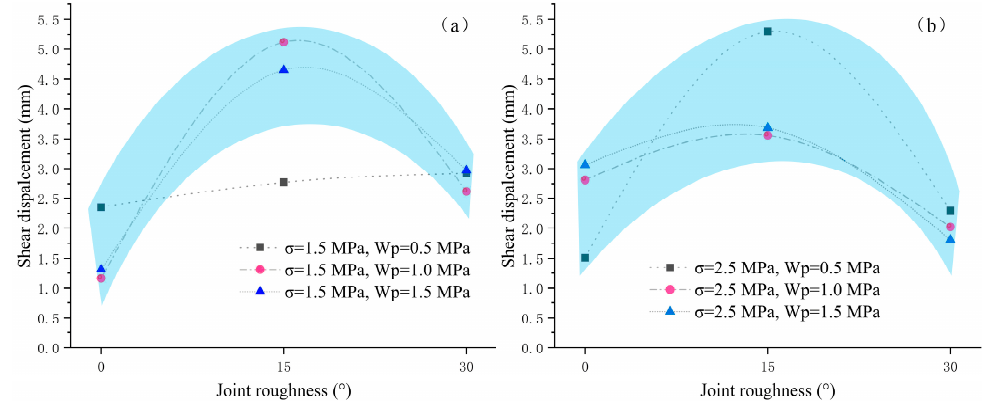
Figure 7. Displacements corresponding to the peak shear stresses under different seepage pressures: ( a ) normal stress is 1.5 MPa; ( b ) normal stress is 2.5 MPa.